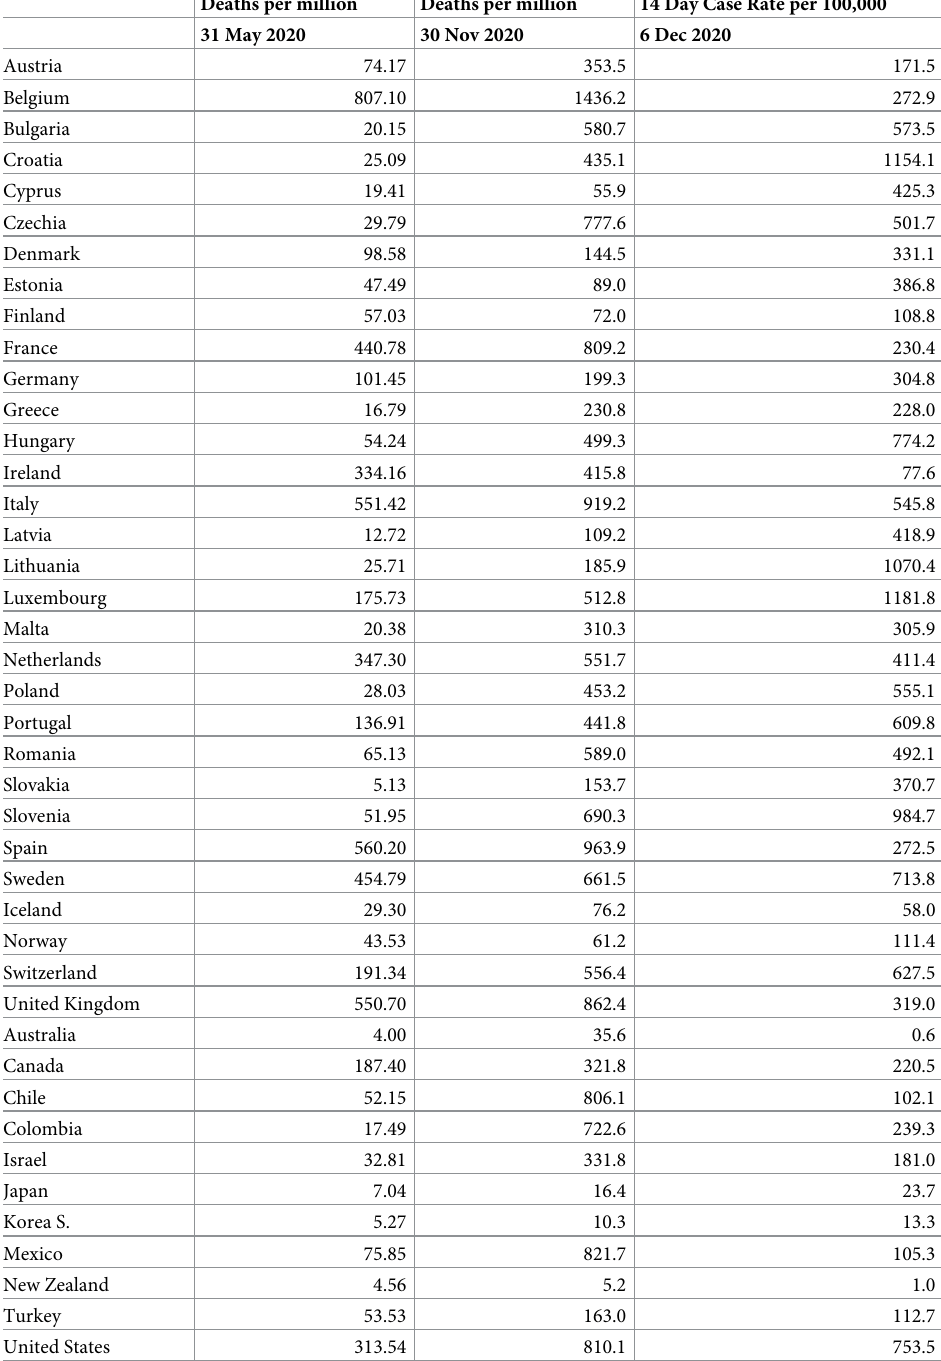
Table 1. Covid-19 incidence in European union and OECD countries at three time points in 2020. Deaths per